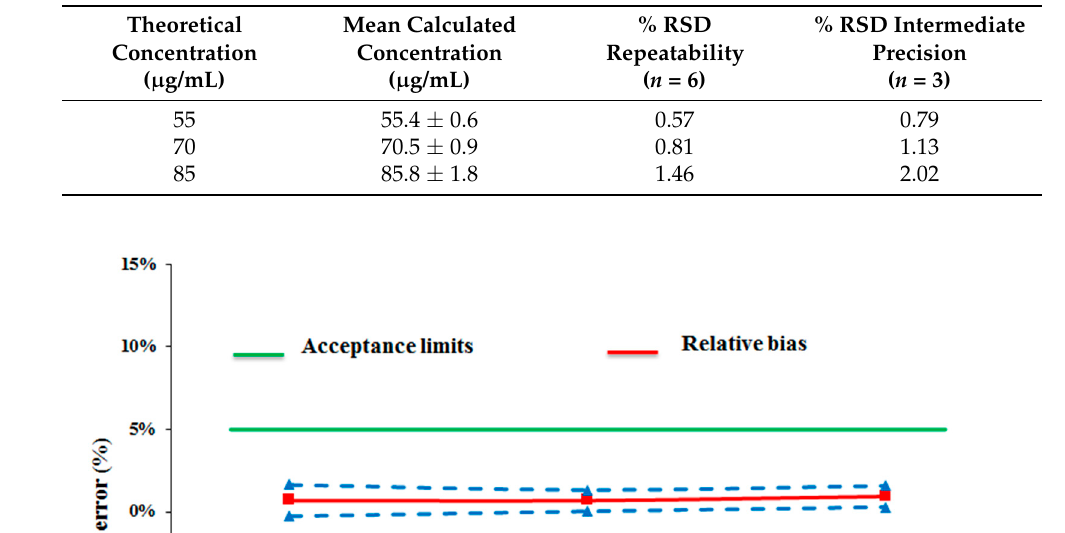
Table 1. This is a table. Tables should be placed in the main text near to the first time they are cited.